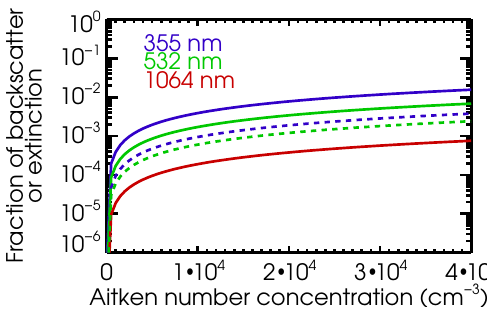
0 Figure 10. The effect on the backscatter coefficient (solid lines) and extinction coefficient (dashed lines) of a narrow Aitken mode with median radius = 15nm, s = 1.48, and varying number concentra- tion, expressed as a fraction backscatter and extinction measured in a typical observation by HSRL-2 on 17 July 2012 during the TCAP